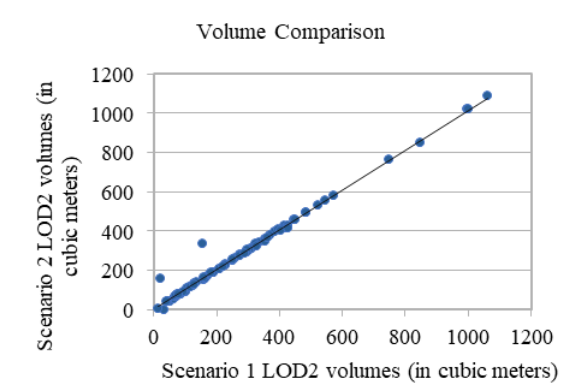
Figure 9. Volume comparison of LOD2 buildings between the two scenarios